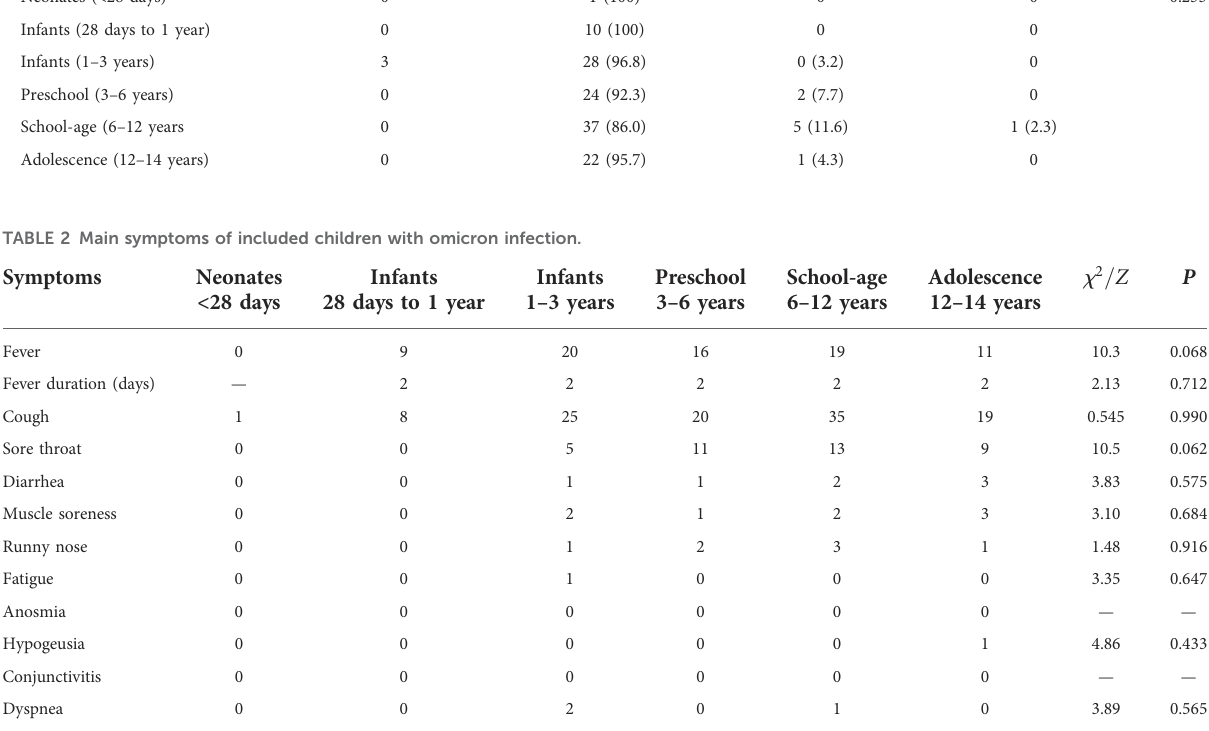
TABLE 1 Demographic and clinical types of children with omicron infection in Changchun, China.